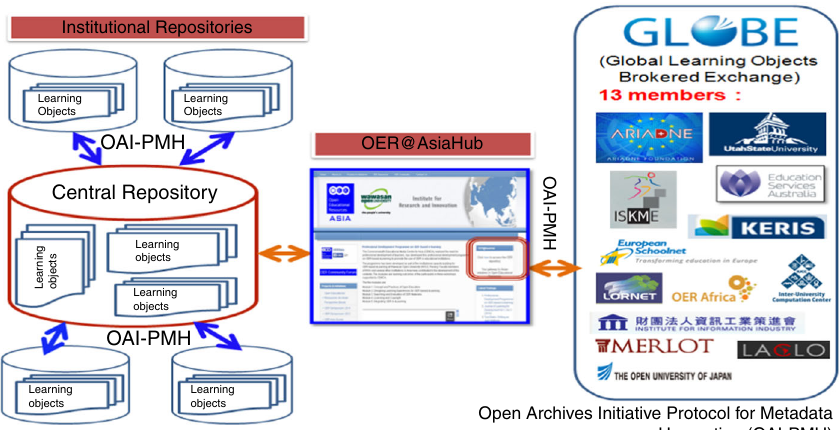
Figure 5. Federated repository